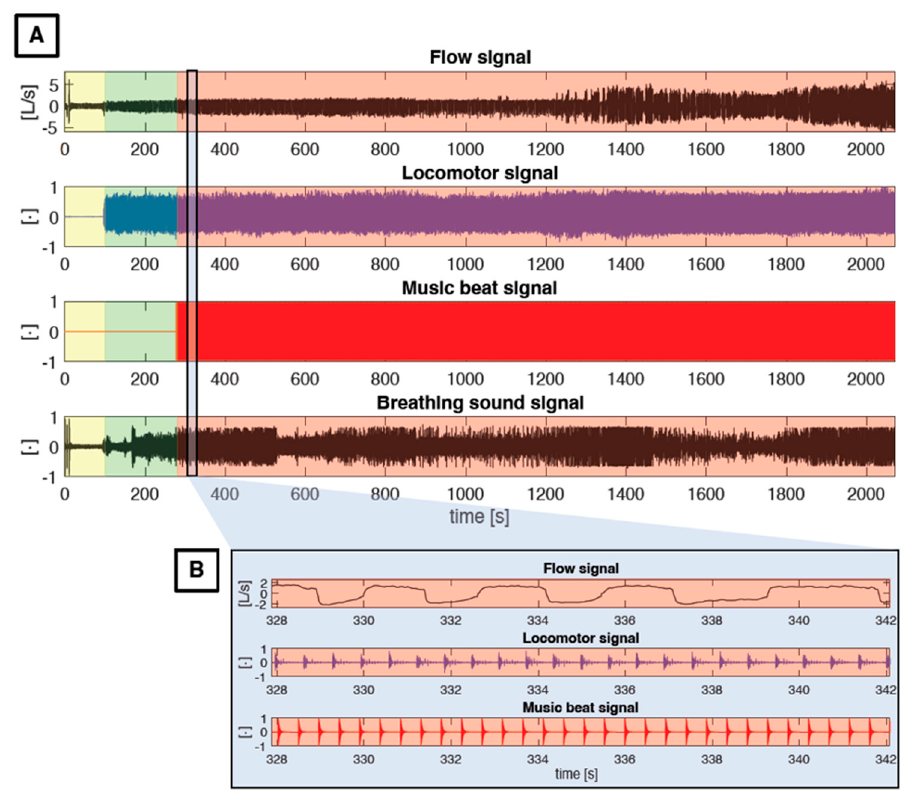
Figure 3. Schematic representation of the different phases of the experimental protocol and the main signals recorded ( A ). The music beat signal allows for the identification of the start of music listening. ( B ) shows an enlarged portion of the three signals used for the analyses of entrainment.